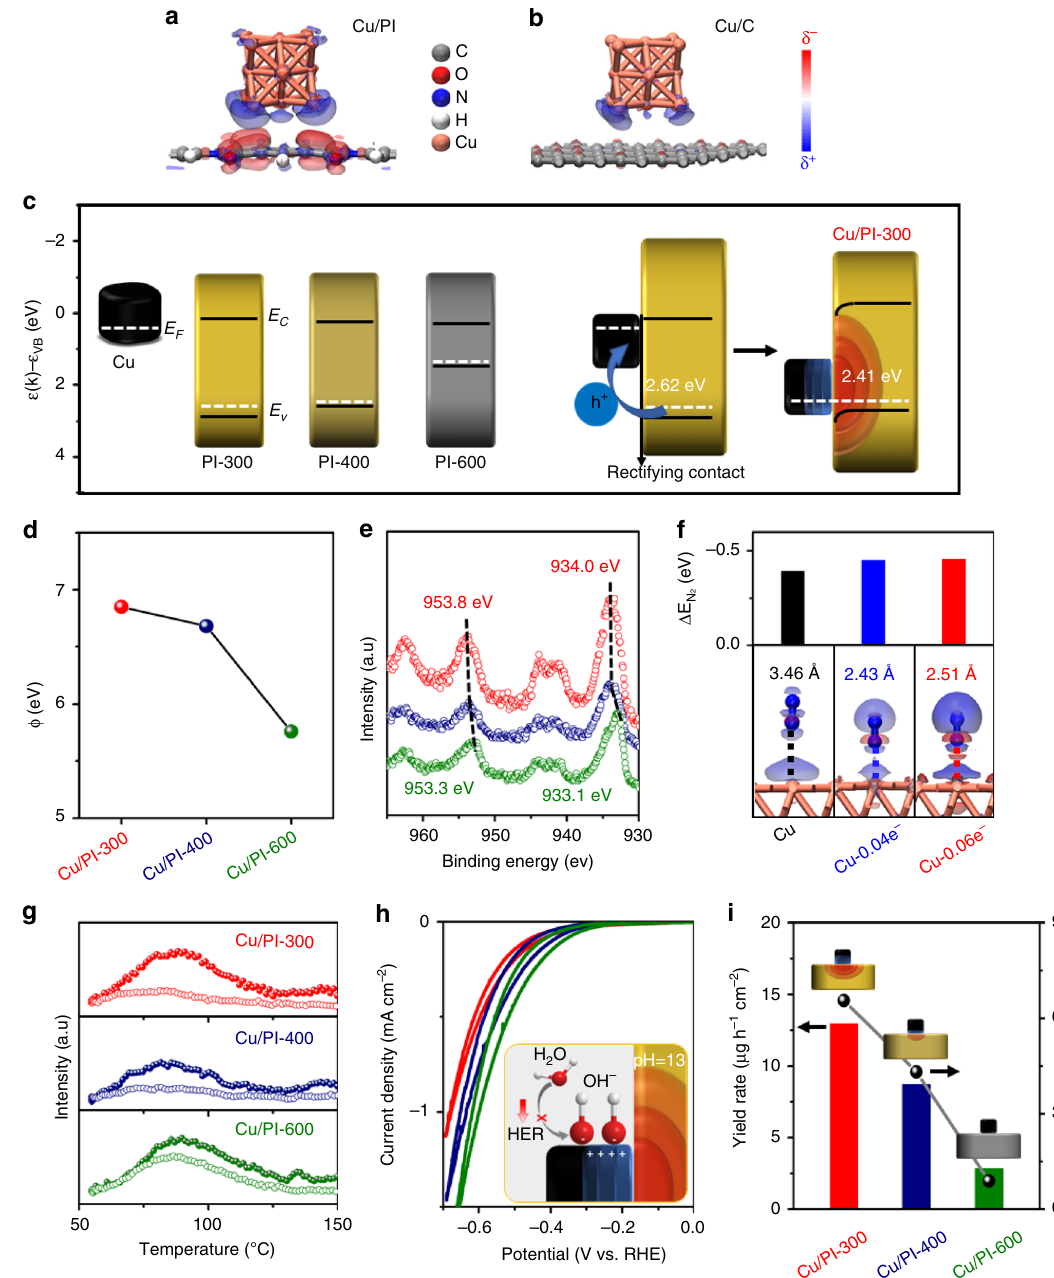
Fig. 3 Effect of electron de fi cient Cu nanoparticles on the catalytic performance. EDD stereograms of a Cu/PI and b Cu/C models. c Experimentally estimated work functions and band structures of Cu and PI components (left) and schematic diagram of rectifying contact of Cu and PI hybrid (right), resulting in electron rich (red) and de fi cient (blue) areas at their interface. The estimated work functions from UPS analysis d and X-ray photoelectron spectroscopy (XPS) Cu 2p spectra e of Cu/PI samples. f The calculated adsorption energies of N 2 molecules on pristine Cu (Cu) and electron-de fi cient Cu (Cu-0.04e − and Cu-0.06e − ) surface. g The N 2 -temperature programmed desorption (TPD) results of Cu/PI catalysts (spheres) and corresponding bare PI supports (circles). h The cyclic voltammograms (CVs) of Cu/PI electrodes (catalyst loading: 1 mg cm − 2 ) at a scan rate of 5 mV s − 1 in Ar-saturated 0.1 M KOH. i The NH 3 yield rates and Faradaic ef fi ciencies of Cu/PI electrodes at − 0.3 V vs. RHE. Insets : f EDD stereograms of N 2 molecules on pristine Cu (Cu) and electron-de fi cient Cu (Cu-0.04e − and Cu-0.06e − ) surface. h the deactivation mechanism of the HER process over electron de fi cient Cu nanoparticles in Cu/PI-300; i proposed electron localization at the Cu-PI